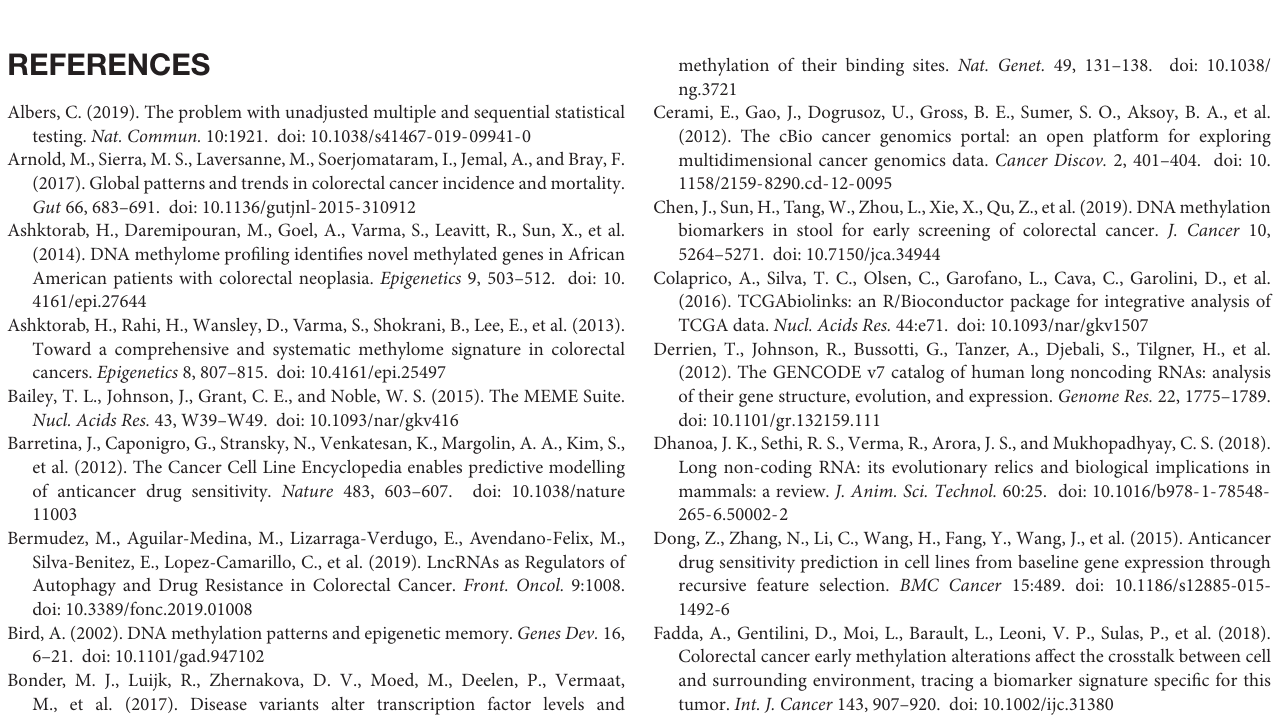
Supplementary Figure 1 | Exploring the association between TF-methylation-lncRNA and OS in colon cancer. (A) Box plots of lncRNAs, DNA methylation sites, lncRNAs, TF-methylation-lncRNA associated p -values ( − log10 transformed, log-rank test). (B) DFS curve for two risk groups in TCGA colon cancer, p- value is calculated from log-rank test. (C) OS curve for two risk groups in GSE17536 dataset, p- value is calculated from log-rank test. (D) OS curve for two risk groups in GSE39582 dataset, p -value is calculated from log-rank